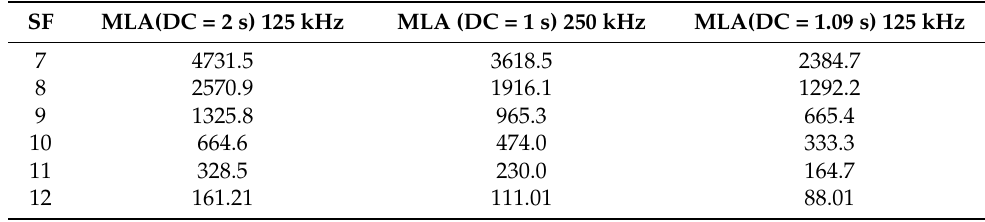
Table 9. Energy harvesting